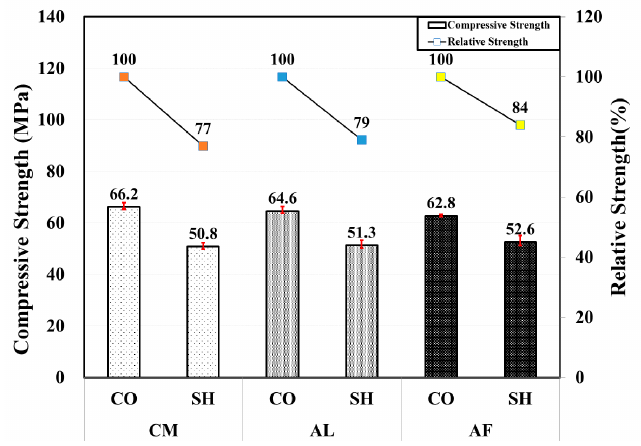
Figure 6. Compressive and relative strength by accelerators for 12-month-old specimens.